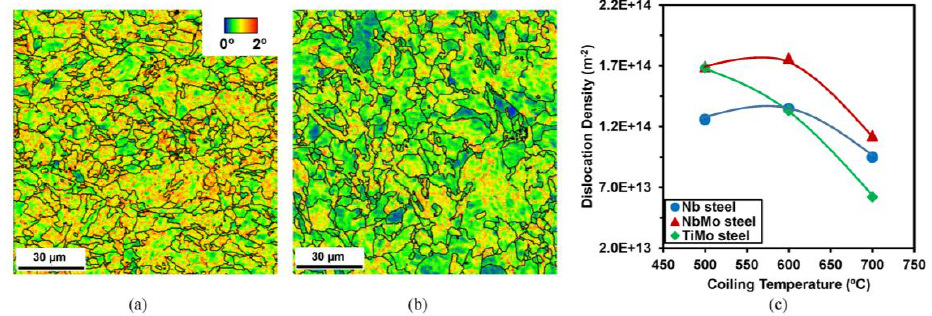
Figure 5. ( a , b ) Kernel maps obtained after a coiling temperature of 600 °C for NbMo and TiMo steels, respectively; and ( c ) dislocation density as a function of coiling temperature for all the microalloyed